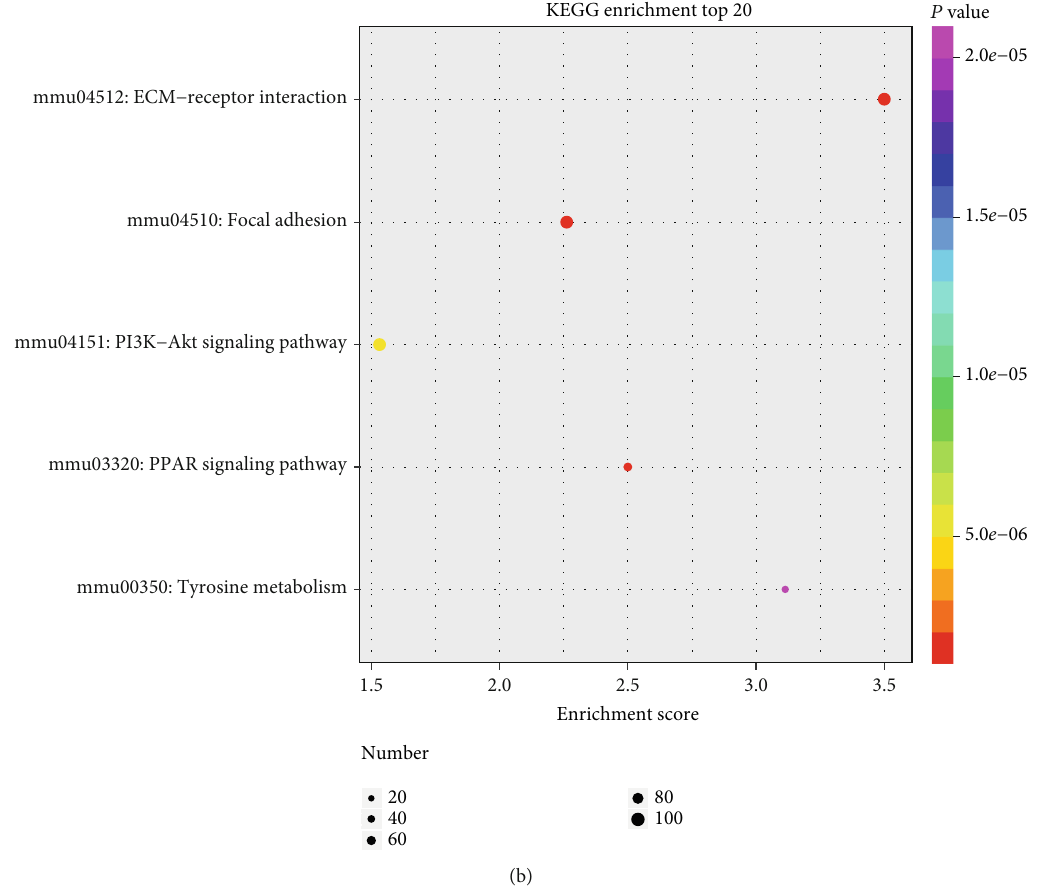
Figure 6: Di ff erential mRNA functional annotation and pathway analysis between undi ff erentiated and di ff erentiated MSCs. (a) GO analysis. (b) KEGG